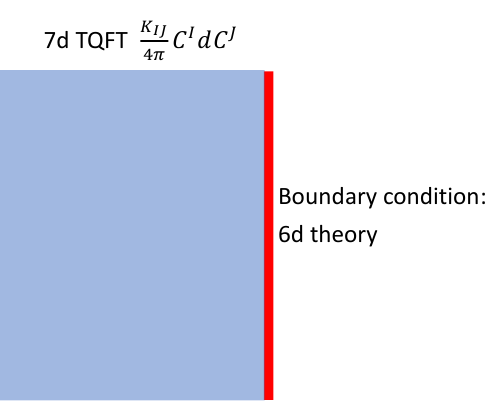
Figure 1 . 6d theories can be viewed as boundary conditions of a 7d